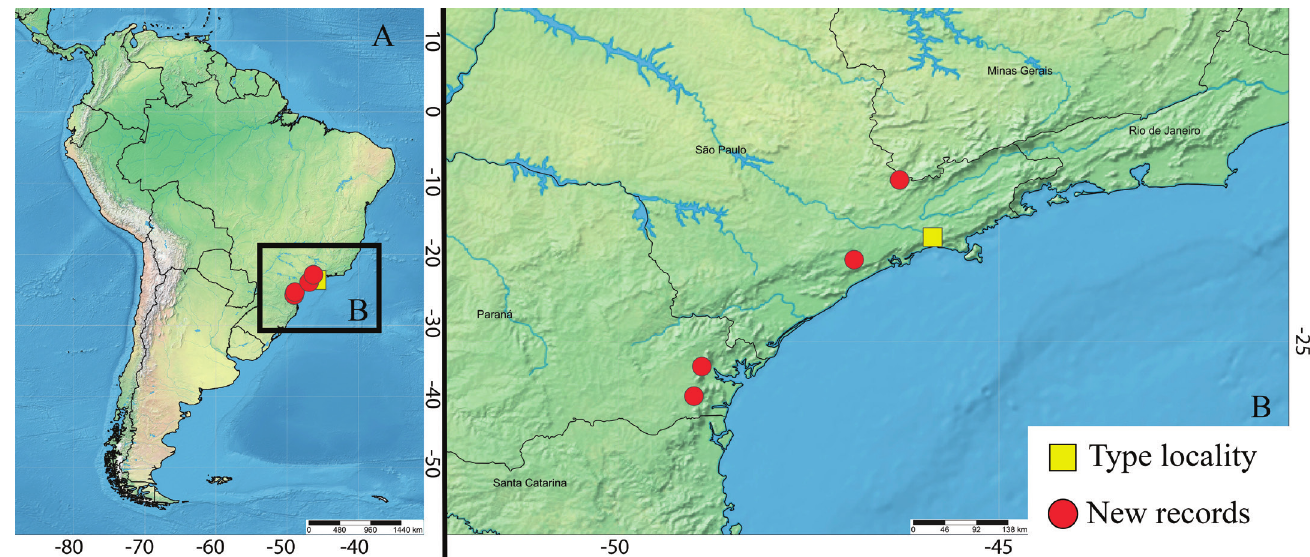
Fig. 1. Occurrence map of Toledopizia salesopolensis . A. South America; B. Sampled areas. Red circles: new records; yellow square: